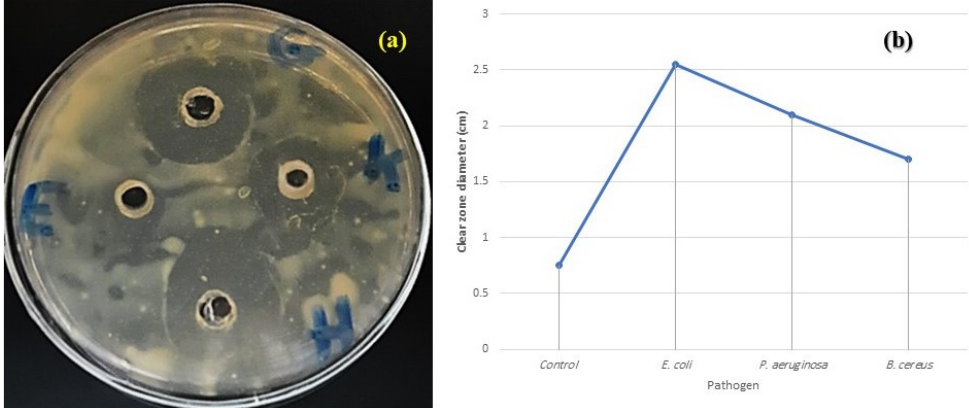
Figure 8. LB agar plate (a) showing the antimicrobial activity of Zantedeschia extract against (b) Histogram of (H): E. coli , (G): P. aeruginosa , (K): B. cereus , compared to control ethanol